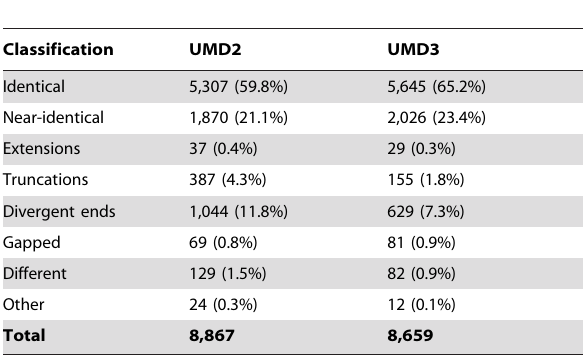
Table 2. Best matches for UMD2 transcripts in the UMD3 annotation determined based on compatibility of exon-intron structures.